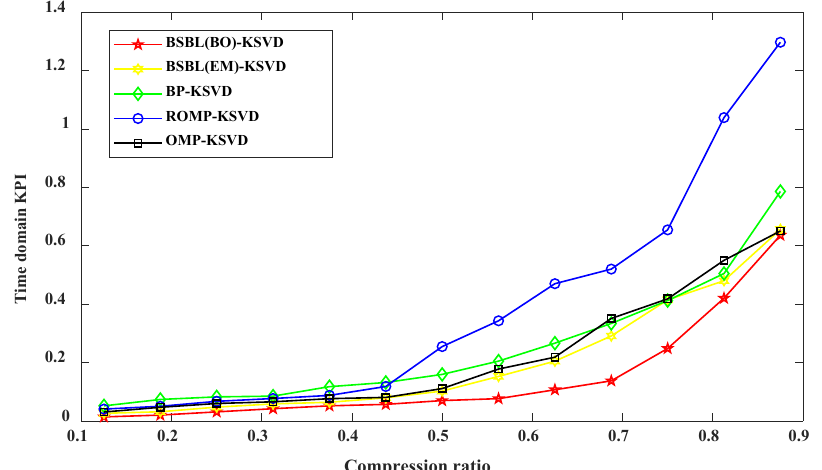
Figure 7. Time-domain comprehensive evaluation index of reconstructed signal under different compression ratios.